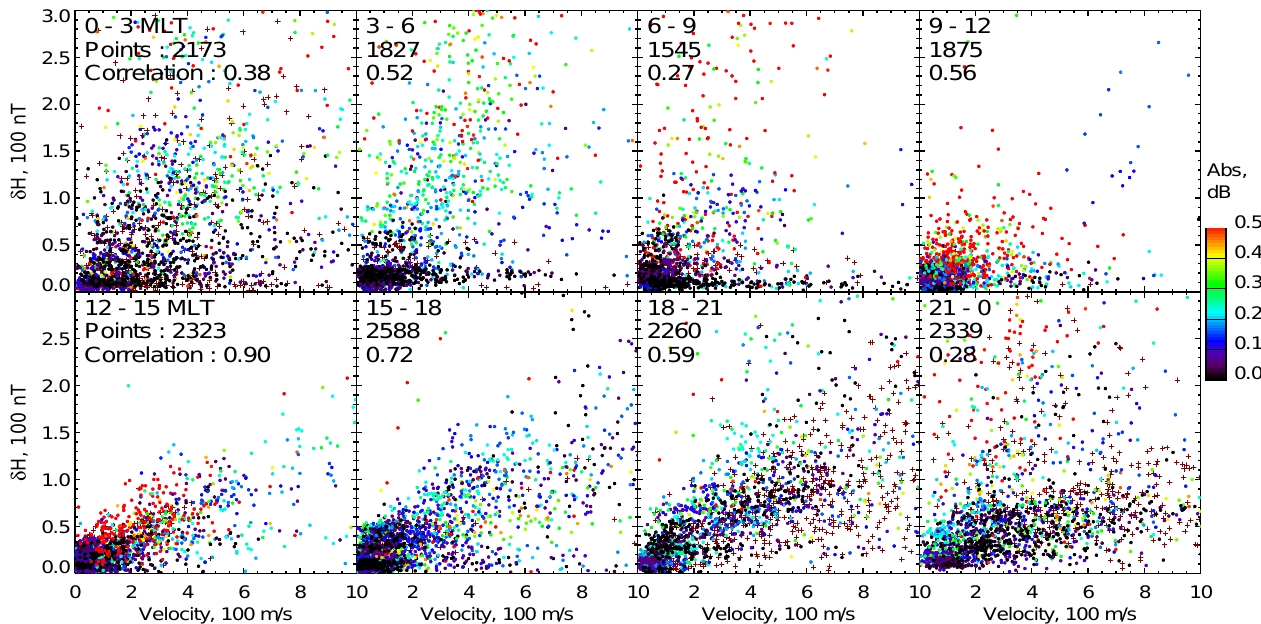
Fig. 3. Scatter plots of magnetic perturbation versus ion velocity for different MLT sectors. The correlation and total number of points are also shown in the top-left corner of each panel. The colour coding is in absorption as shown to the right of the plot. The points with no simultaneous absorption measurements are shown by dark red pluses. The bin-averaged perturbation is shown by the red histogram. as the correlation was higher in panel (b) and structuring was more pronounced in panel